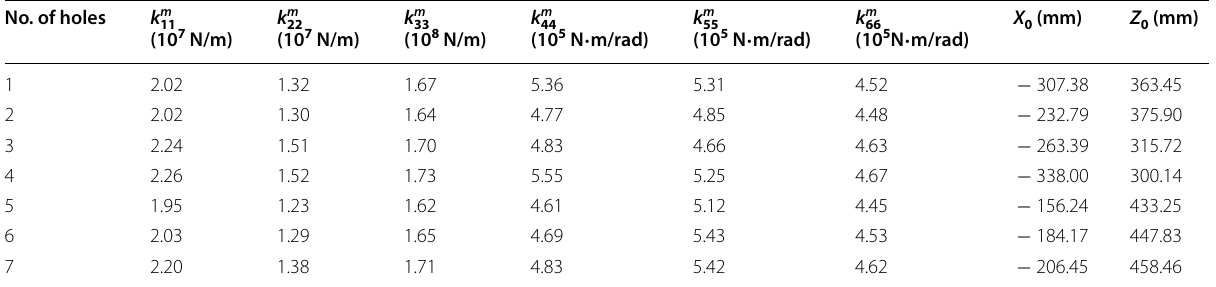
Table 5 Stiffness and position variables of the parallel mechanism for drilling each hole when the worktable locates at the optimal position No. of